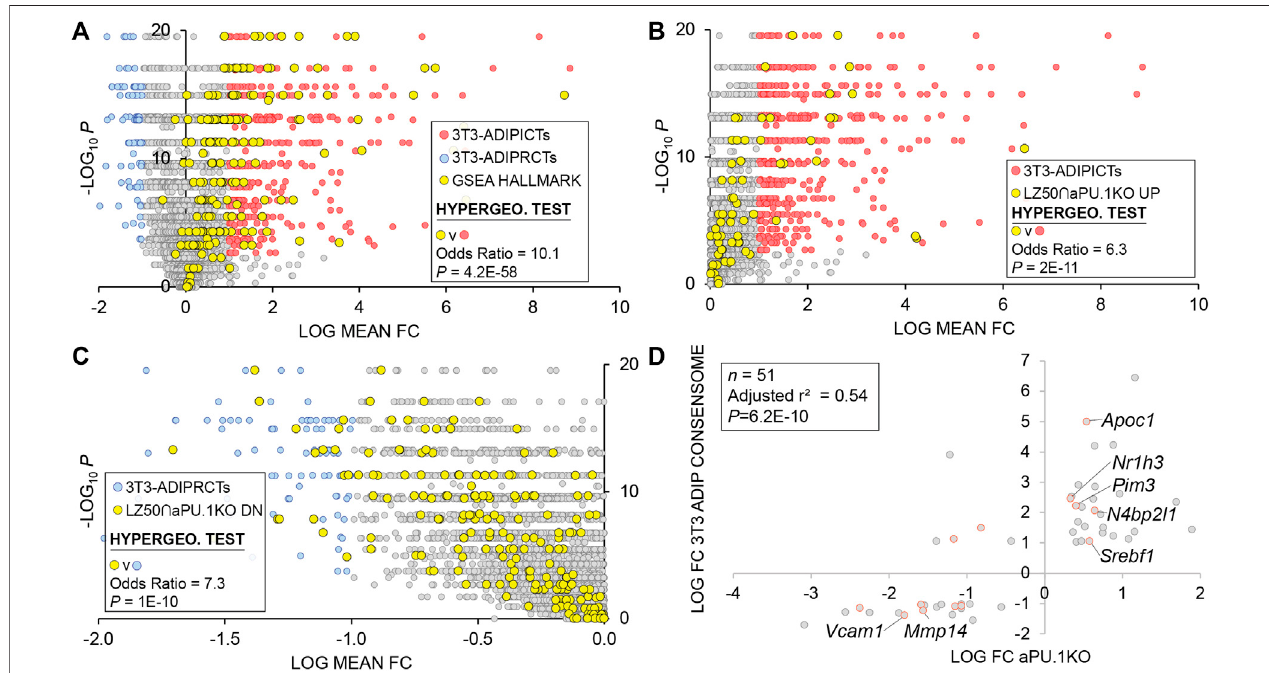
FIGURE 6 | 3T3-L1 Adipogenic Differentiation Consensome. The mouse 3T3-L1 adipogenesis transcriptomic consensome ranks mouse genes based on their discovery rates across fi ve independent, publicly archived 3T3-L1 adipogenesis transcriptomic datasets. Hypergeometric test odds ratio and associated p -value are indicatedineachpanel. (A) Validationofthe3T3-L1adipogenesisconsensomeagainsttheGSEAadipogenesisHallmarkgeneset. (B) Over-representationofaPU.1KO- induced LZ50 genes among 3T3-ADIPICTs. (C) Over-representation of aPU.1KO-repressed LZ50 genes among 3T3-ADIPRCTs. (D) Correlation between aPU.1KO log FC and adipogenesis log mean FC.